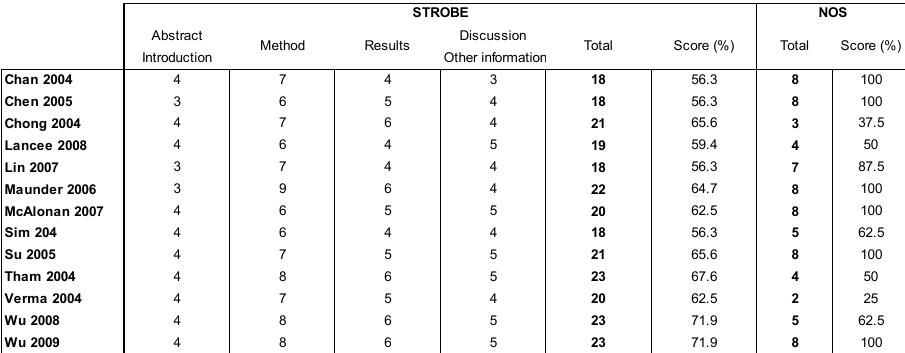
Figure A1. Quality of articles using the Newcastle–Ottawa scale (NOS). (N/A : Not applicable)